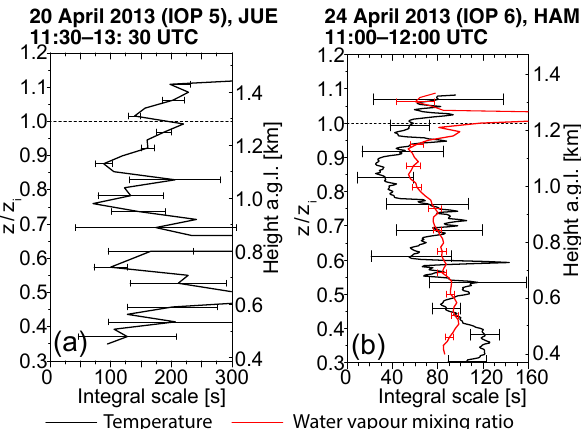
Figure 6. Integral scales of the temperature fluctuations (black) and humidity fluctuations (red) in the convective boundary layer derived from high-resolved observations obtained between 11:30 and 13:30 on 20 April 2013 (IOP 5) and 11:00 and 12:00UTC on 24 April 2013 (IOP 6) during HOPE-Jülich. Heights are normalized with re- spect to the height of the convective boundary layer z i . Adapted from Behrendt et al. (2015), Muppa et al. (2016), and Di Girolamo et al.